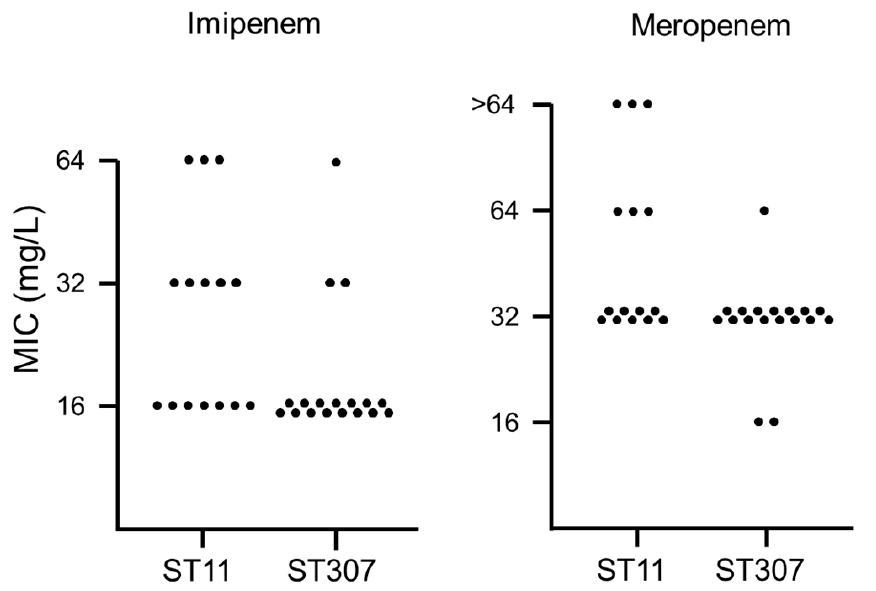
Figure 1. Distribution of the minimum inhibitory concentrations (MICs) of carbapenem antibiotics (imipenem and meropenem) for the two main clones of KP-Kp isolates—ST11 and ST307. The number of dots indicates the number of isolates with the corresponding MIC.